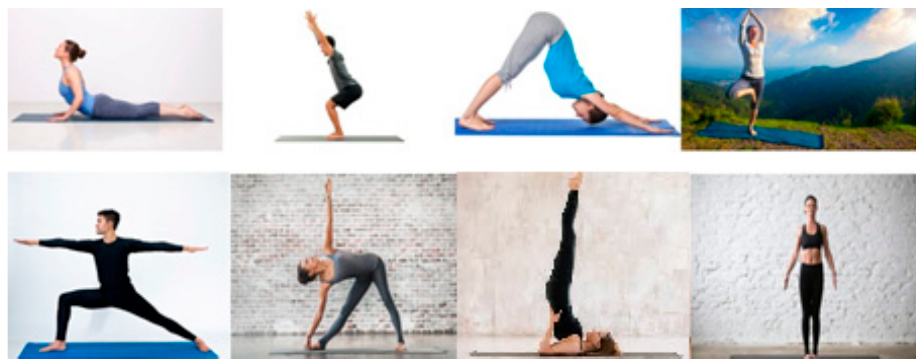
Figure 8. Various frames of yoga postures (cobra, chair, dog, tree, warrior, triangle, shoulder stand, neutral) in dataset used for training the Y_PN-MSSD model. neutral) in dataset used for training the Y_PN-MSSD model.